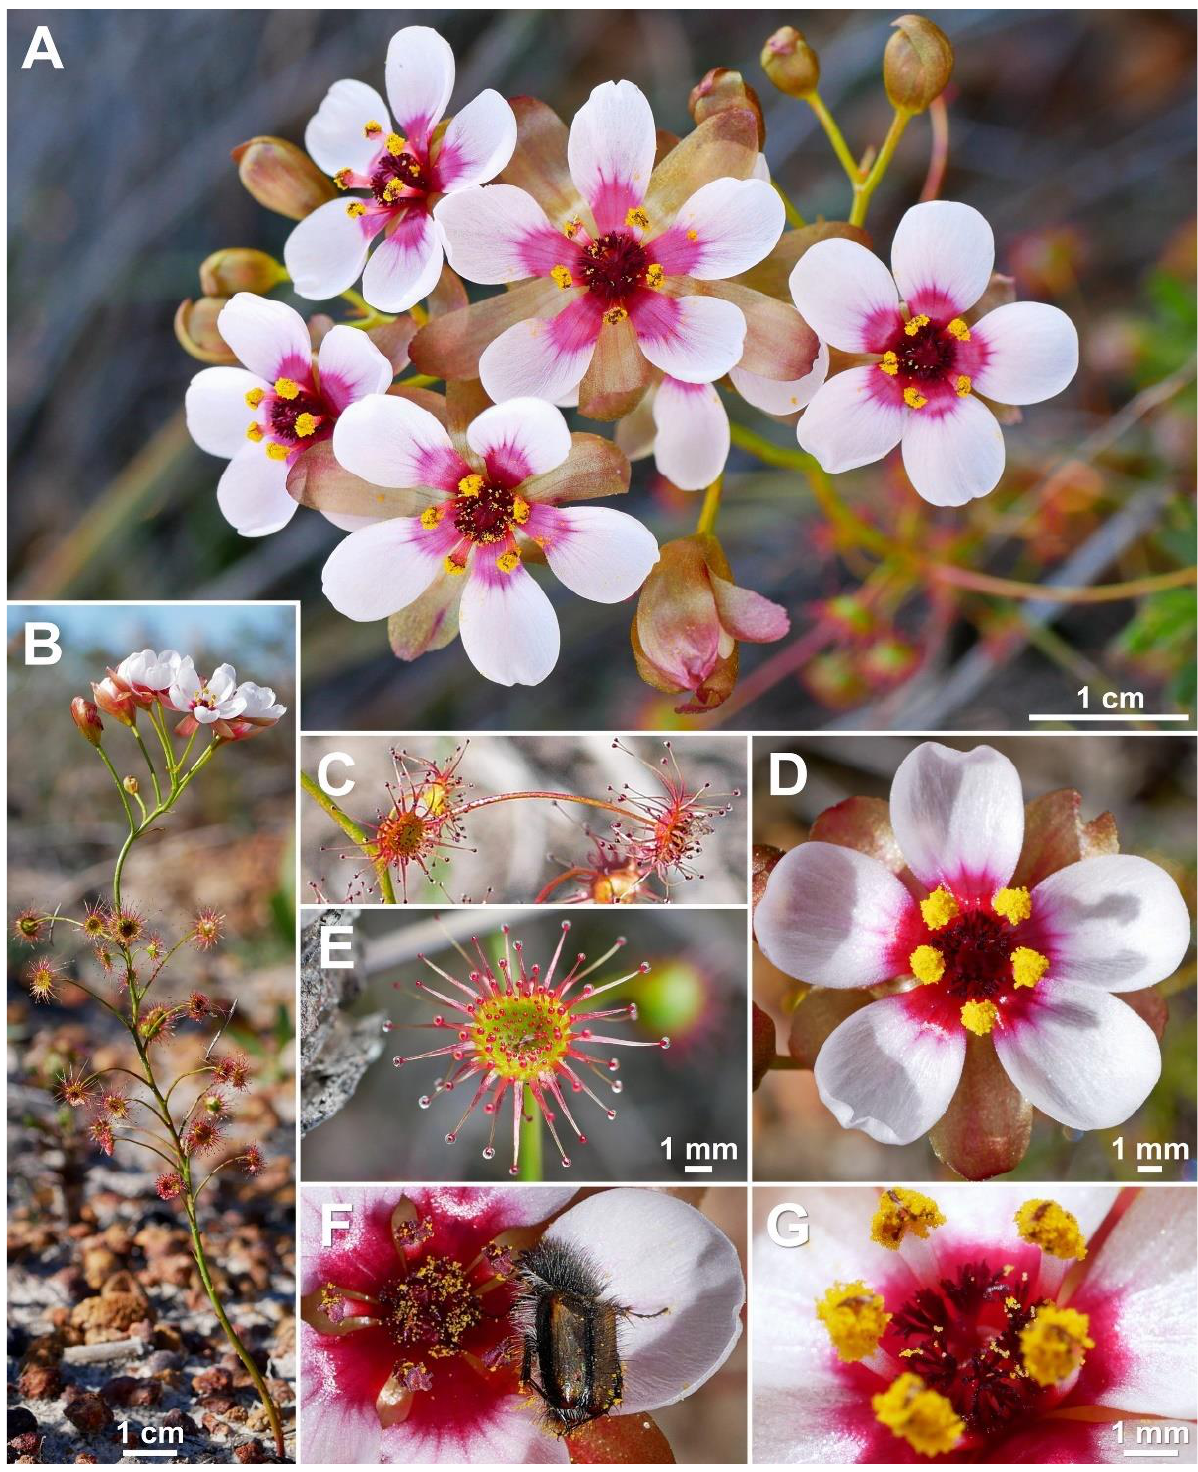
Figure 13. Drosera macropetala (Diels) T.Krueger & A.Fleischm. ( A ) flowers of a single plant in diffuse light, this species often has 3 – 5 flowers open simultaneously; ( B ) habit of a relatively small individual; ( C ) upper leaf exhibiting two smaller axillary leaves emerging from the leaf axil; ( D ) flower in bright sunlight; ( E ) lamina; ( F ) flower with observed pollinator (a beetle of the family Scarabaeidae); and ( G ) stamens and styles. All from near Dandaragan, Western Australia, 16 August 2021. Images: T. Krueger.